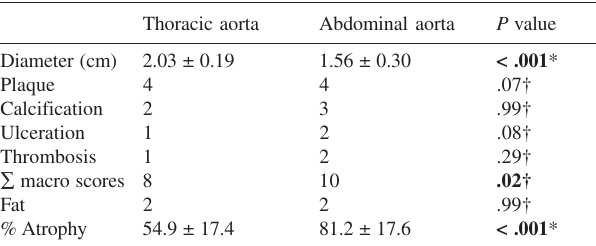
Table 2 - Mean and standard deviation of the diameters and percentage of medial layer atrophy, as well as median of the semiquantitative scores of the thoracic and abdominal